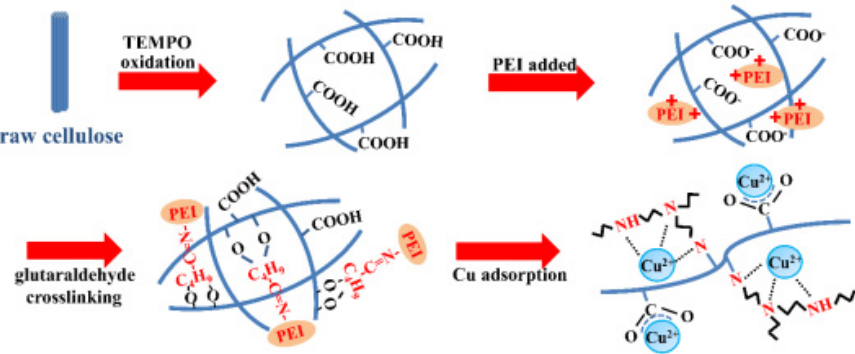
Figure 8. TEMPO-mediated oxidized cellulose nanofibrils improved with PEI. Reprint from [114] Copyright 2016, with permission of Elsevier.